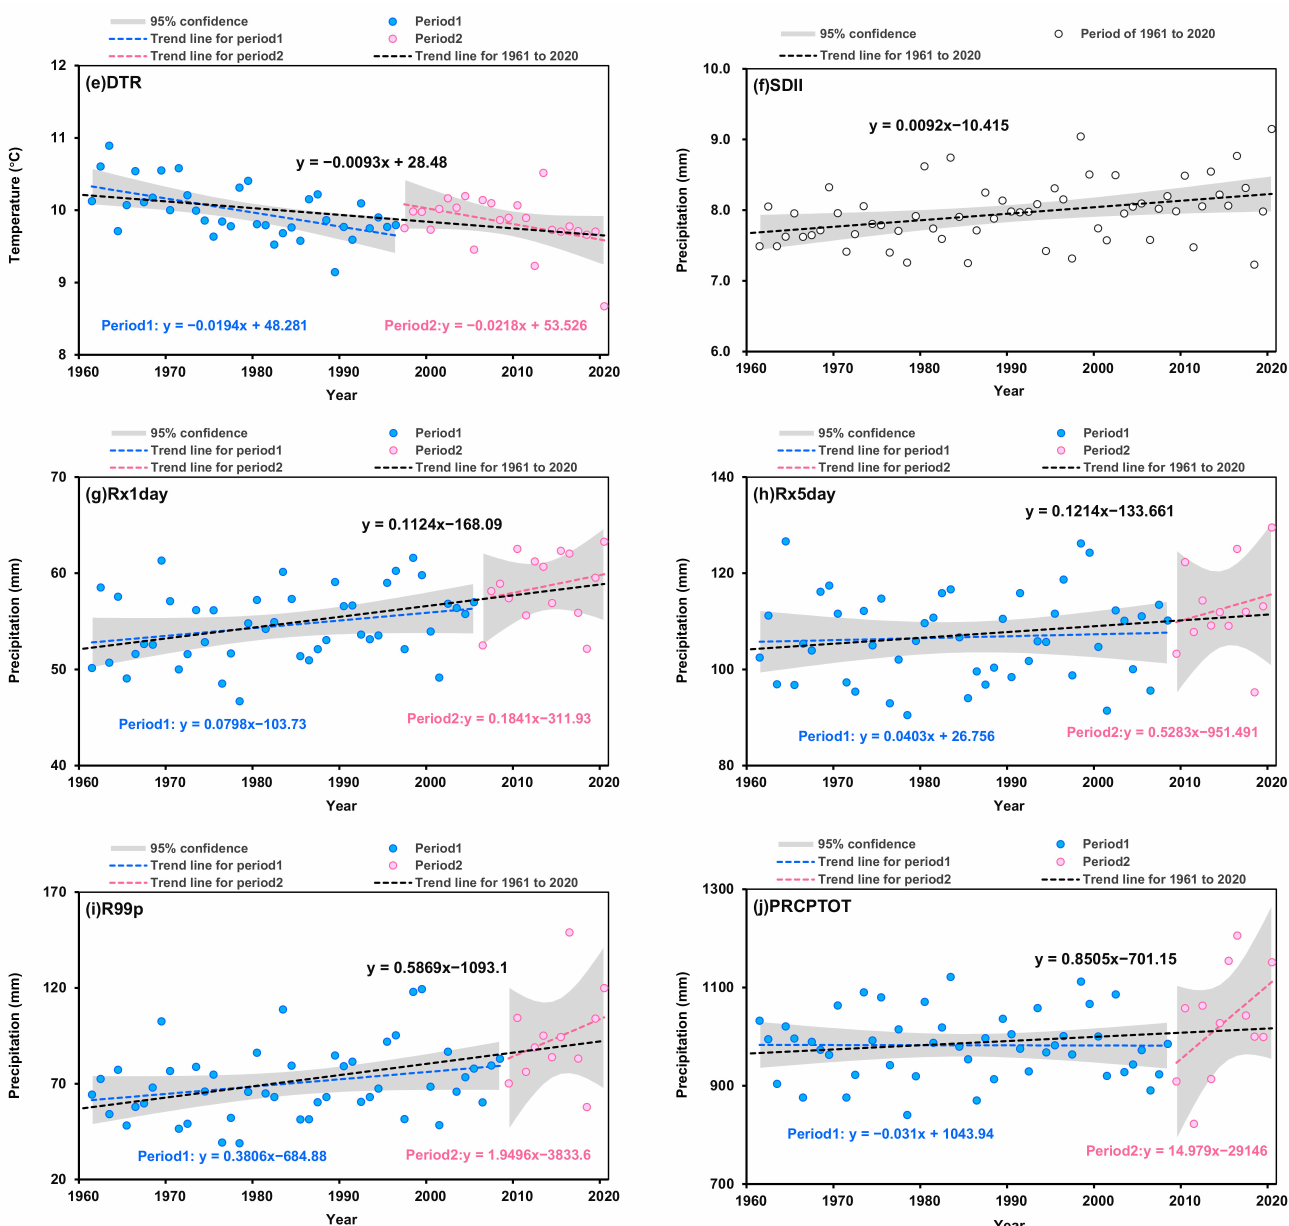
Figure 3. Regional average of annual series in extreme precipitation and temperature indices during 1961 to 2020: ( a ) TXx; ( b ) TXn; ( c ) TNx; ( d ) TNn; ( e ) DTR; ( f ) SDII; ( g ) Rx1 day; ( h ) Rx5 day; ( i ) R99p; ( j )